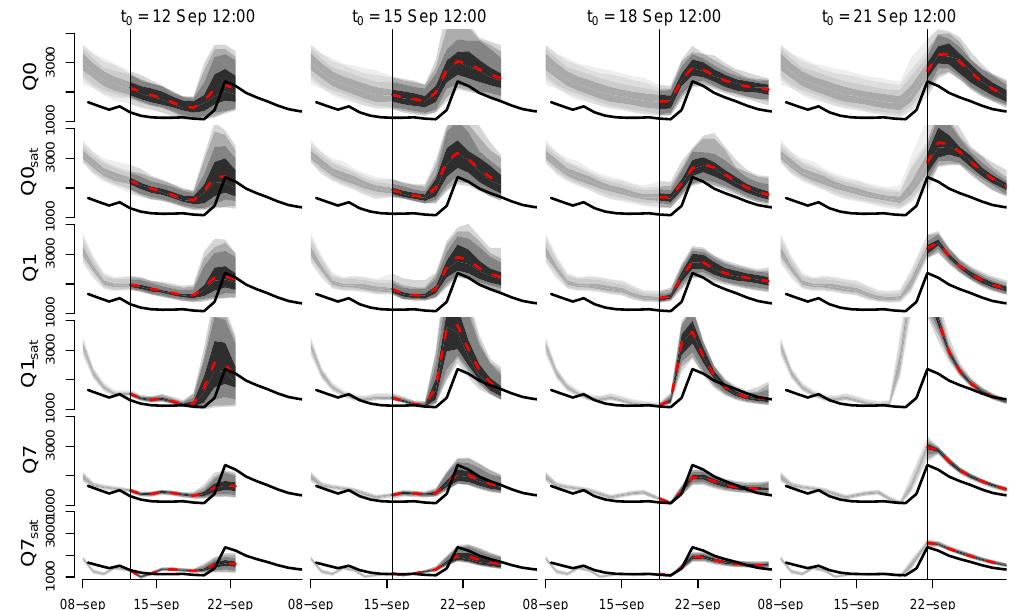
Figure 5. Example forecast time series of discharge at the outlet of the Upper Danube catchment (Fig. 1) for part of the hindcasting period. In grey are all model realizations, the ensemble mean is given by the red dashed line and solid black line gives the observed discharge value. Each column of figures gives the hindcast for a particular time, indicated by the vertical line.